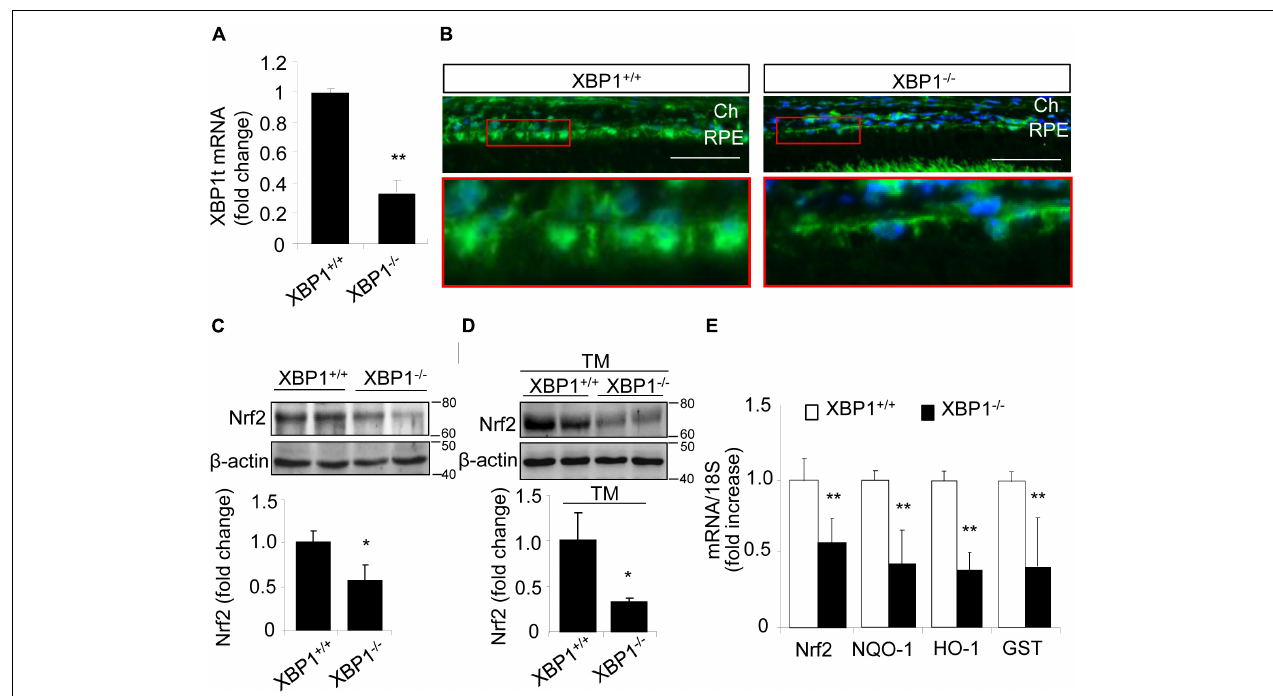
FIGURE 1 | Decreased Nrf2 expression in the RPE of XBP1 KO mice. (A) Total XBP1 mRNA level in the WT and KO mice eyecups (including choroid and the RPE) was detected by real-time PCR (mean ± SD, n = 7 for WT, n = 5 for KO, ∗∗ p < 0.01). (B) Retina sections were stained with anti-Nrf2 antibody (green) and DAPI (blue) was used to stain all nuclei. (Scale bar: 50 µ m; Ch, choroid; RPE, retinal pigment epithelium). (C) Expression of Nrf2 in the WT and KO eyecups was determined by Western blot analysis and semi-quantified by densitometry (mean ± SD, n = 4, ∗ p < 0.05). (D) Freshly isolated eyecups were incubated with 10 µ g/ml tunicamycin for 6 h, and the protein level of Nrf2 was detected by Western blot and semi-quantified by densitometry (mean ± SD, n = 3, ∗ p < 0.05). (E) mRNA levels of Nrf2, NQO-1, HO-1, and GST in the WT and KO eyecups was detected by real-time RT-PCR (mean ± SD, n = 5, ∗∗ p <